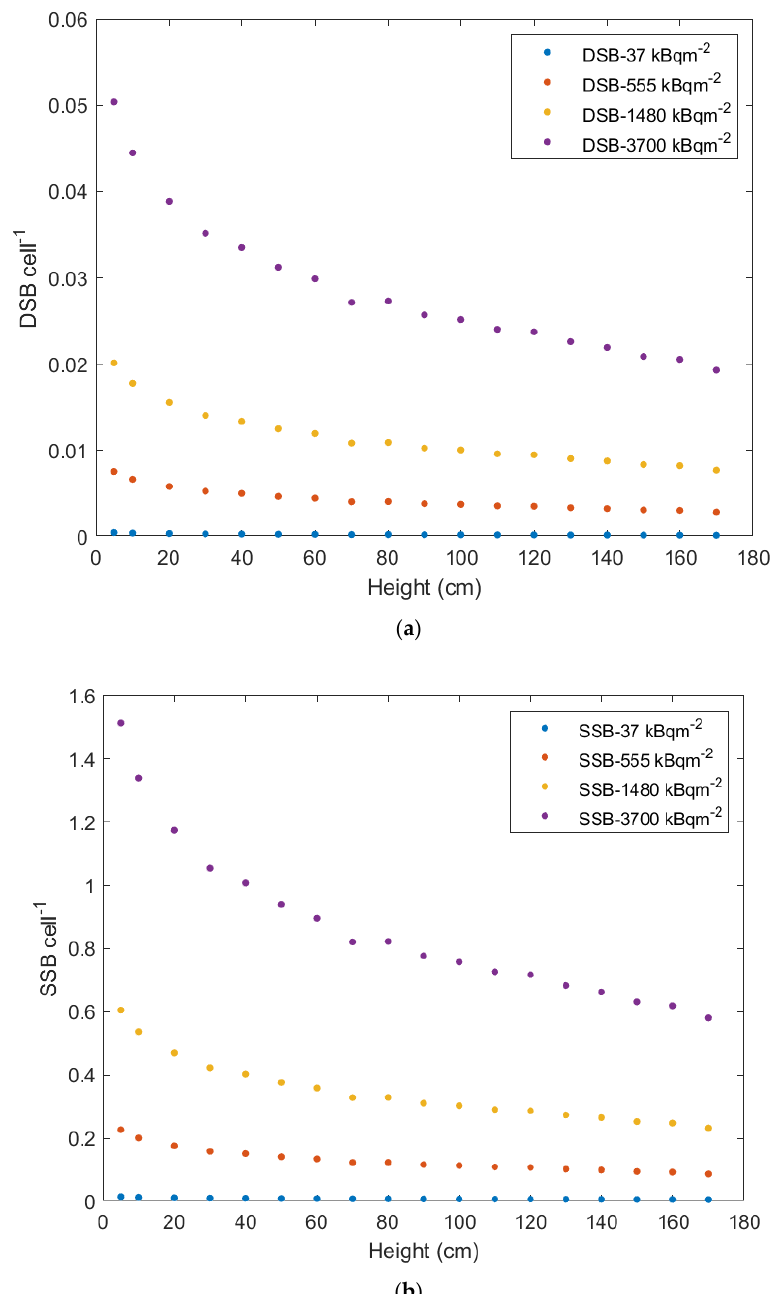
Figure 3. Estimation of the number of ( a ) DSBs and ( b ) SSBs per cell, respectively, induced by different levels of 137 Cs contamination in the ground, for the exposure time of one week, according to our MCDS simulations. The first thing to note is that the analogy between SSBs and DSBs seems to be in the range reported in irradiated typical mammalian cells [66]. It can also be noted that, for the higher value of surface activity, an exponential decrease is observed in both the numbers